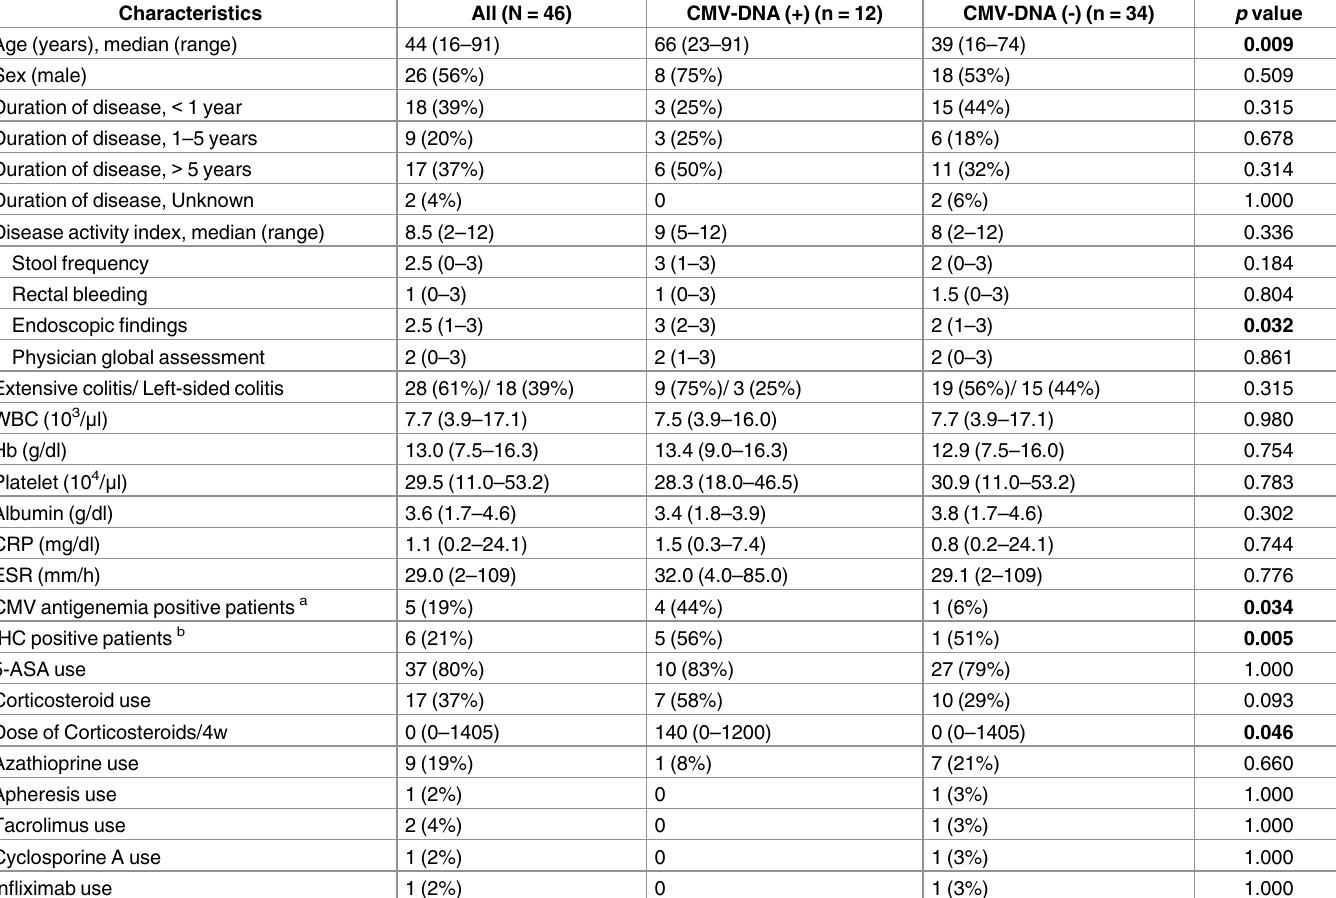
Table 1. Baseline characteristics in CMV-DNA+ and CMV-DNA − patients (N = 46).